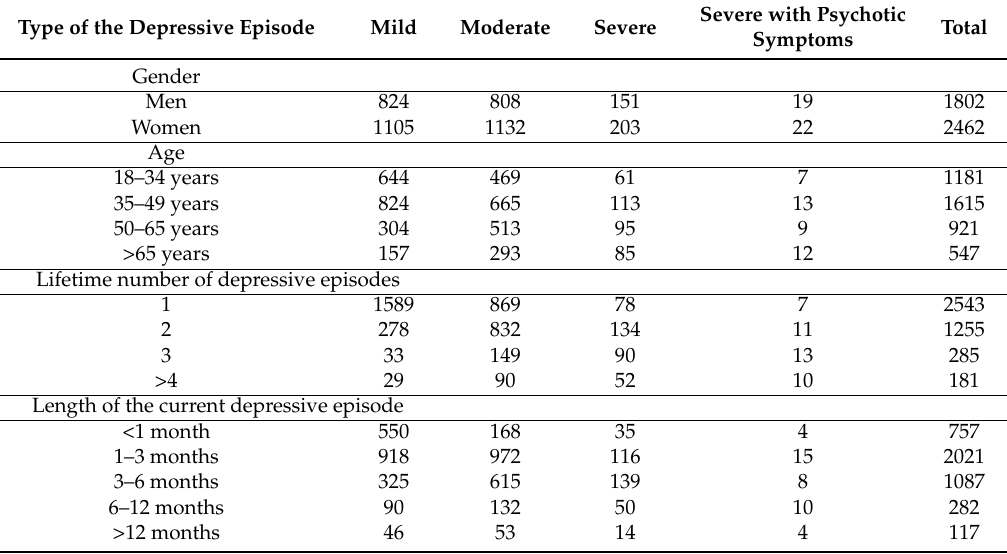
Table 1. Participants’ characteristics stratified by the type of depressive